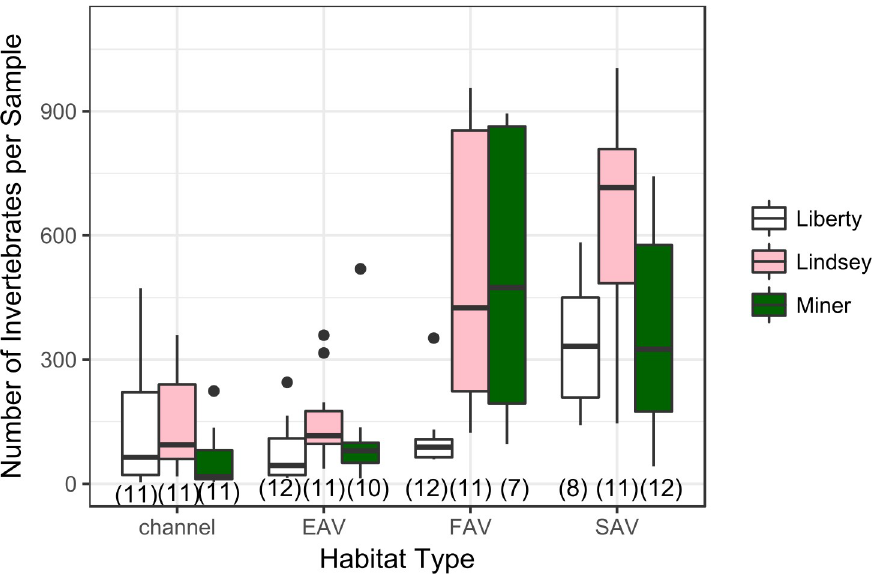
Fig 2. Distribution of total catch in each area and habitat type. Sample size in parentheses below boxes. Four outliers in FAV and SAV samples with catch > 1000 not shown. Models support significantly higher catch in SAV than in other habitats and significantly higher catch with the sweep net in FAV (see Table